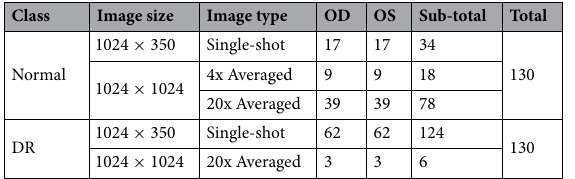
Table 1. Dataset characteristic. Note that: OD and OS stand for right eye and left eye,